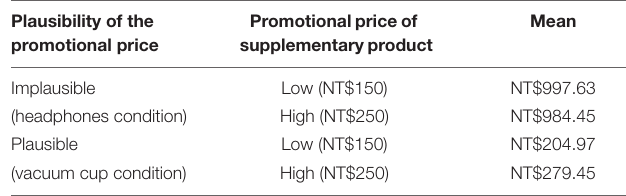
TABLE 1 | Willingness to pay for the headphones (or vacuum cup) after termination of the promotion. Plausibility of the promotional price